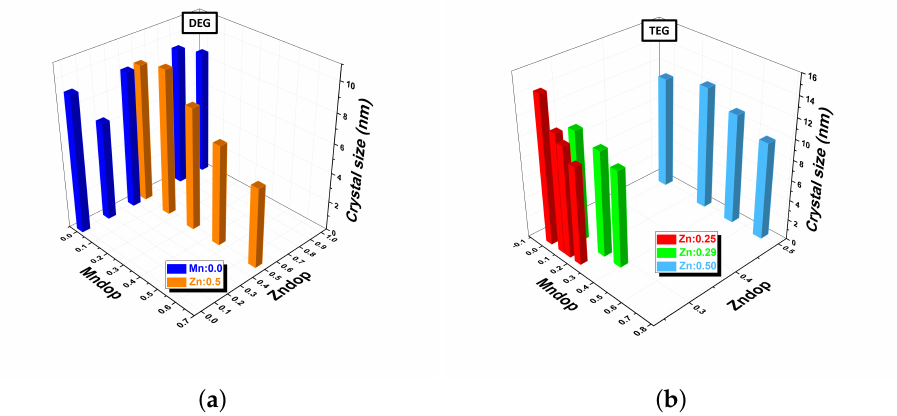
Figure 2. Variation of crystal size as a function of Zn and Mn doping for nanoparticles synthesized with: ( a ) diethylene glycol (DEG) and ( b ) tetraethylene glycol